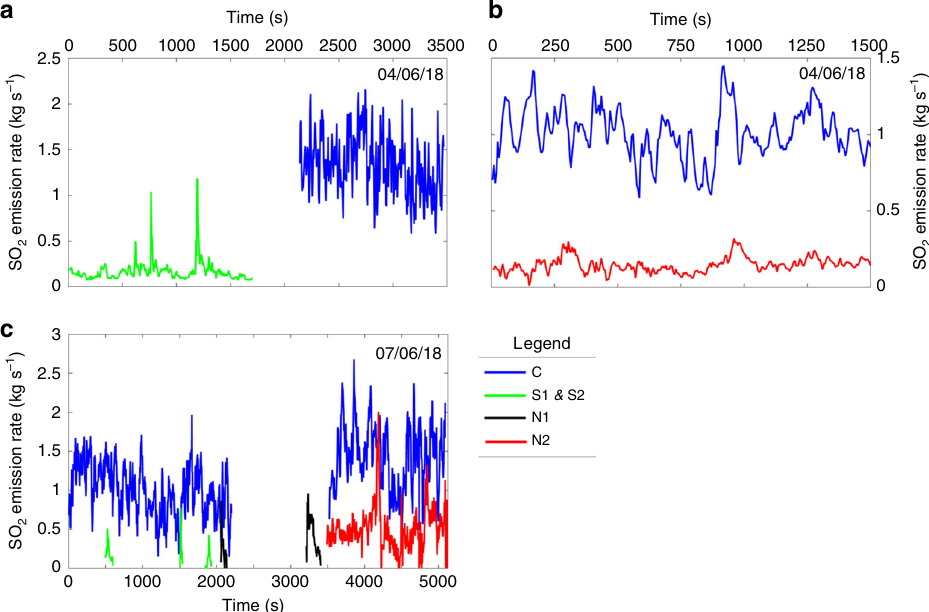
Fig. 3 Vent-speci fi c SO 2 emissions. SO 2 emissions from UV camera acquisitions on 04/06/18 and 07/06/18. In a two separate explosions from S1, and elevated emissions from area C; in b passive emissions from N2 and C and in c explosive emissions only from S1, S2 and N1, alongside passive emissions from C and combined passive and explosive emissions from N2. Note the difference in y -axis scale between